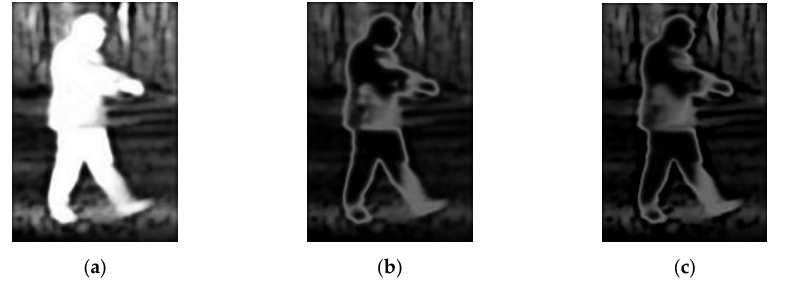
Figure 4 . ( a ) Intensity adjusted image 𝐼 𝐺𝑀𝐴 ; ( b ) The difference image between 𝐼 𝐺𝑀𝐴 and 𝐼 𝐺𝑀 ; ( c ) The difference image between 𝐼 𝐺𝑀𝐴 and 𝐼 𝐺 .